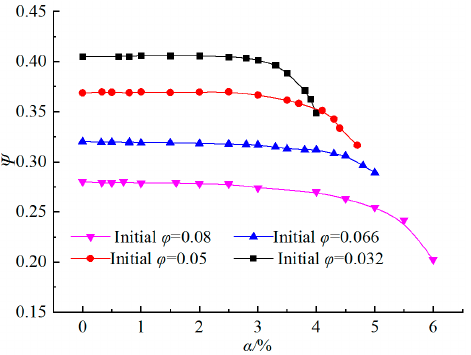
Figure 6. Liquid flow rate change for different inlet void fraction and initial water flow rates.